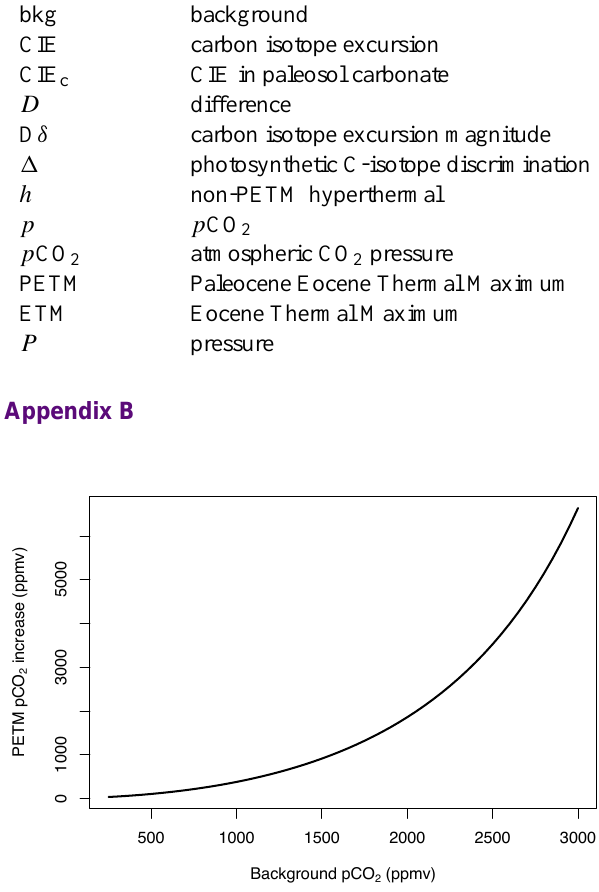
Figure B1. Figure showing p PETM and change in PETM p CO 2 (D p PETM ) across a range of assumed background p CO 2 conditions from 250 to